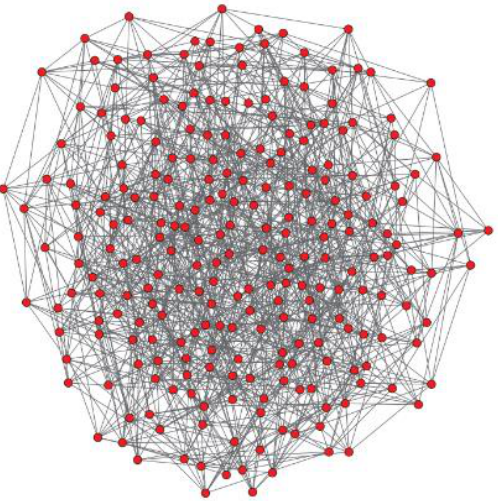
Figure 5. The structure of the generated small-world